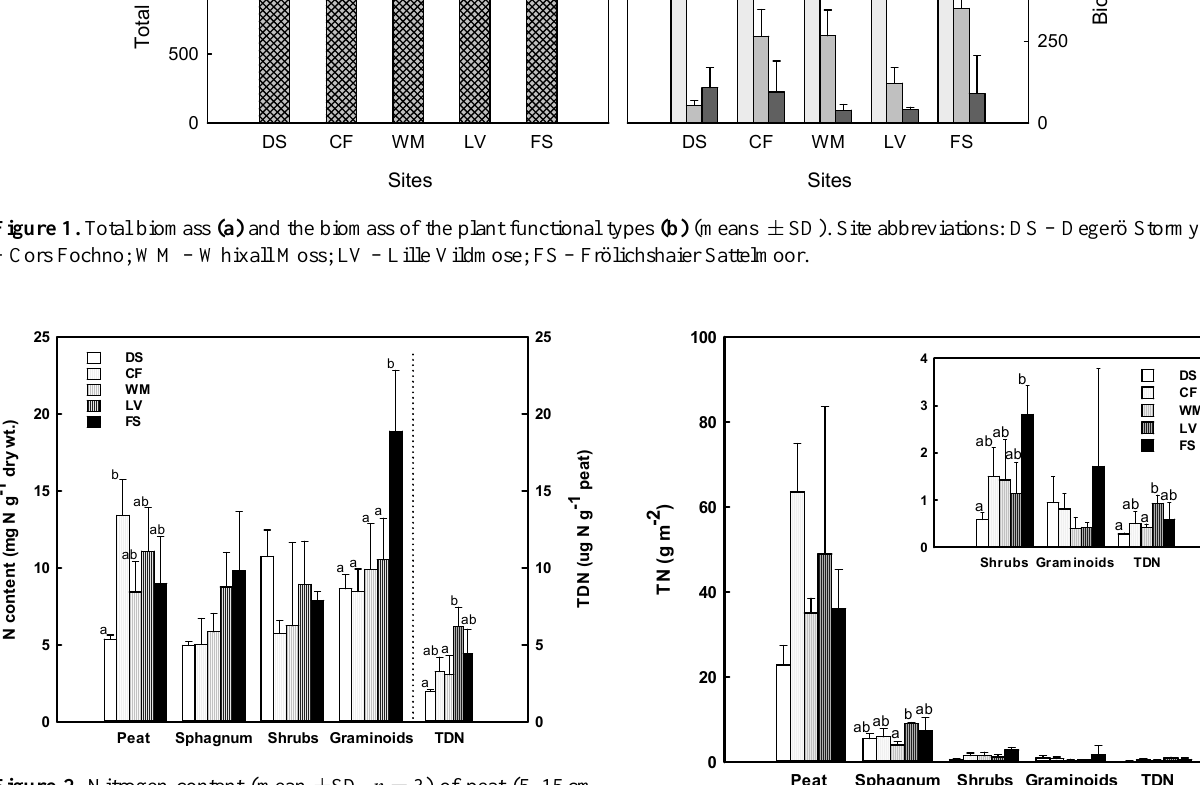
Figure 2. Nitrogen content (mean ± SD, n = 3) of peat (5–15cm depth), Sphagnum (0–5cm below surface), shrub, graminoid, and total dissolved nitrogen (TDN) (0–15cm depth) pools at the end of the experiment. Letters a and b – significant differences in the mean values of the sites at each pool (one-way ANOVA, Tukey test). A bar without a letter – no significant difference. Site abbreviations: